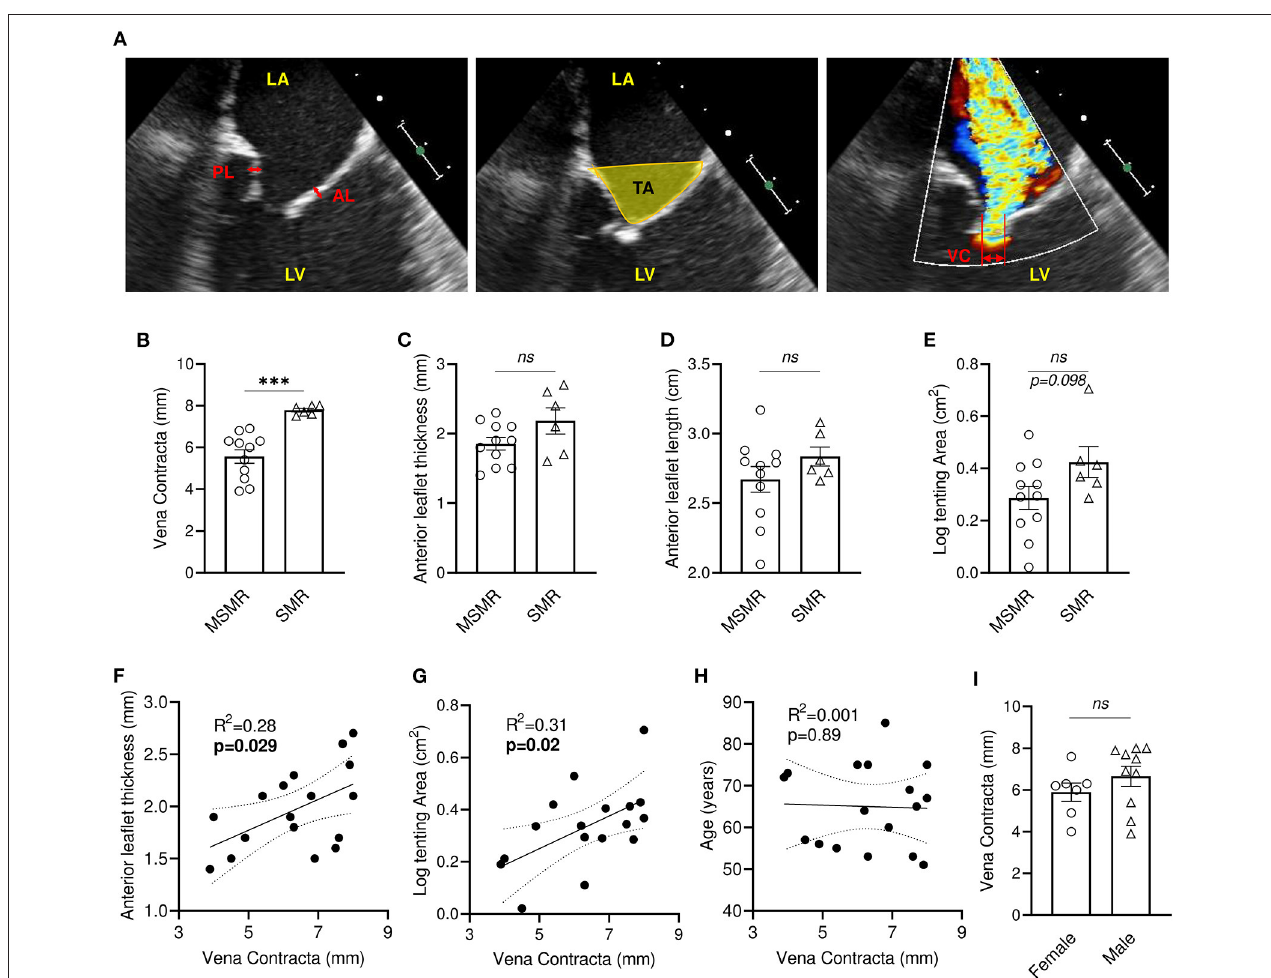
FIGURE 1 | Mitral regurgitation is associated with leaflet thickening and increased tenting area in patients with IMR. (A) Anterior and posterior mitral valve leaflet thickness were measured in the middle portion of the leaflet (left: bidirectional red arrows). Tenting area was measured as the area surrounded by leaflets and the line between annuluses on apical 3ch-view in mid-systole (middle: yellow area). Vena contracta (VC) width was measured as the narrowest width of mitral regurgitation jet (right: bidirectional yellow arrow). Comparison of VC (B) , anterior leaflet thickness (C) , anterior leaflet length (D) , tenting area (E) between patients presenting moderately severe MR (MSMR) ( n = 11) and severe MR (SMR) ( n = 6). Linear correlation between VC and anterior leaflet thickness (F) , tenting area (G) , anterior leaflet length (D) and age (H) . (I) VC in female ( n = 7) and male ( n = 10). LA, left atrium; LV, left ventricle; AL, anterior mitral valve leaflet; PL, posterior mitral valve leaflet. ns, no-significant, *** p < 0.001. Thin dotted line shows the 95% confidence